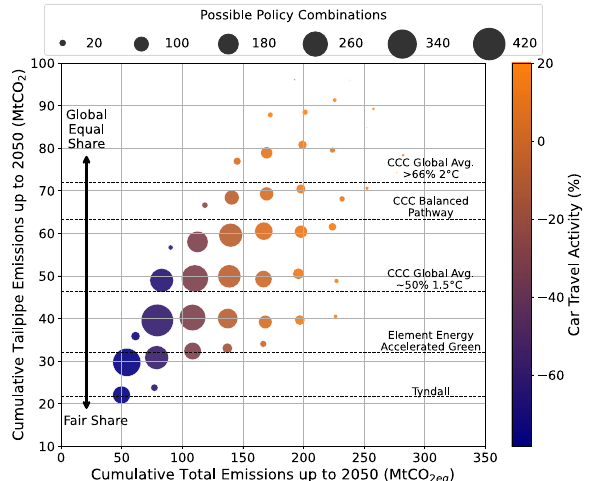
Fig. 4 | The relationship between cumulative tailpipe CO 2 emissions and total CO 2eq emissions for different policy combinations. Cumulative tailpipe emis- sions and total emissions, including use-phase (tailpipe and EV electricity), WTT fuel and embedded emissions, between 2020 and 2050, are plotted for varying magnitudes of car travel activity, scrapping, light-weighting, retro fi tting, ICEV phase-out, regulated EV manufacture and electricity decarbonisation policies. Magnitudes of modal shift are distinguished by colour with blue (dark) corre- sponding to a modal shift of − 80% and orange (light) to a modal shift of +20% (baseline case). The results are grouped by number of policy combinations within that emissions range with the largest bubble corresponding to 400 distinct com- binations of the policies and the smallest bubble to 2. Five carbon budgets are plotted along the tailpipe emissions axis (y axis) because the carbon budgets are limited to the boundary of cars in London and do not include emissions outside London, such as electricity generation emissions or car manufacturing